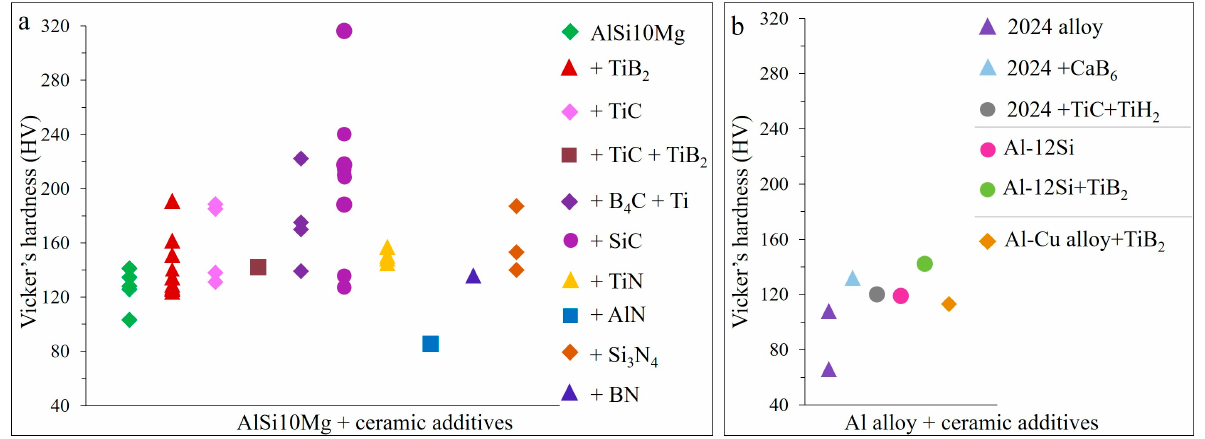
Figure 25. Hardness results of LPBF prepared ceramic particulate reinforced AlSi10Mg ( a ) and other Al alloys ( b ) (data from [11,13,28,31,64,70,71,73,77,78,80,82,83,89,90,92–96,98–105]).